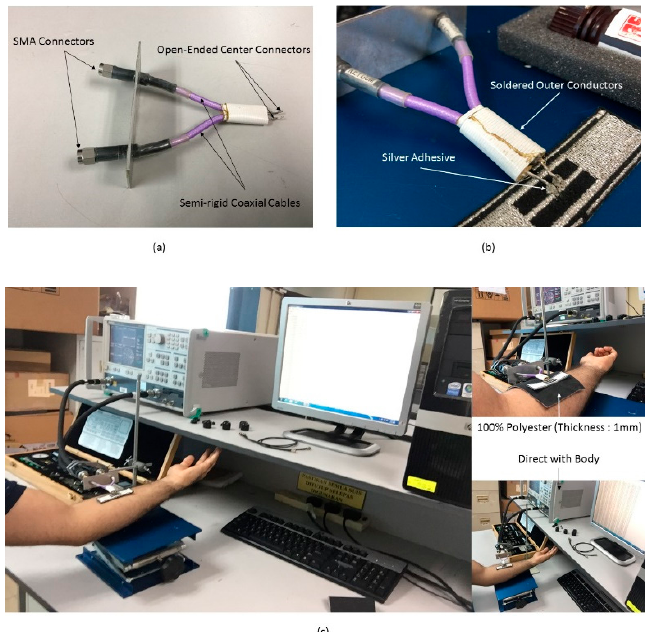
Figure 6. ( a ) Differential probe. ( b ) Open-ended side of semi-rigid cables. ( c ) Measurement setup for tag antenna.